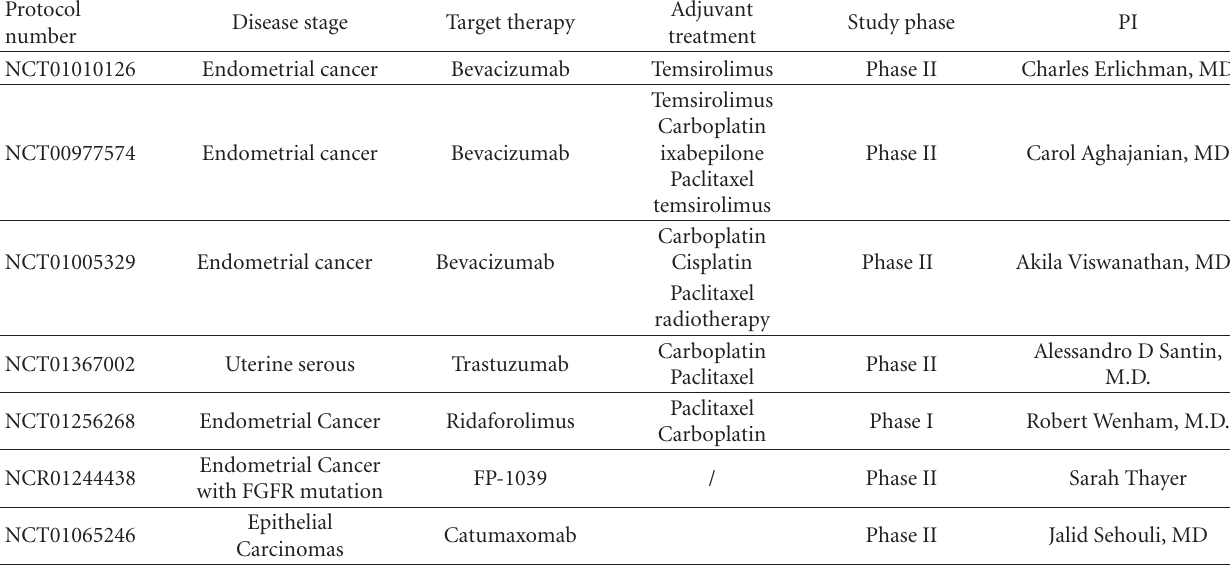
Table 5: Ongoing treatment studies evaluating MoAbs in endometrial cancer